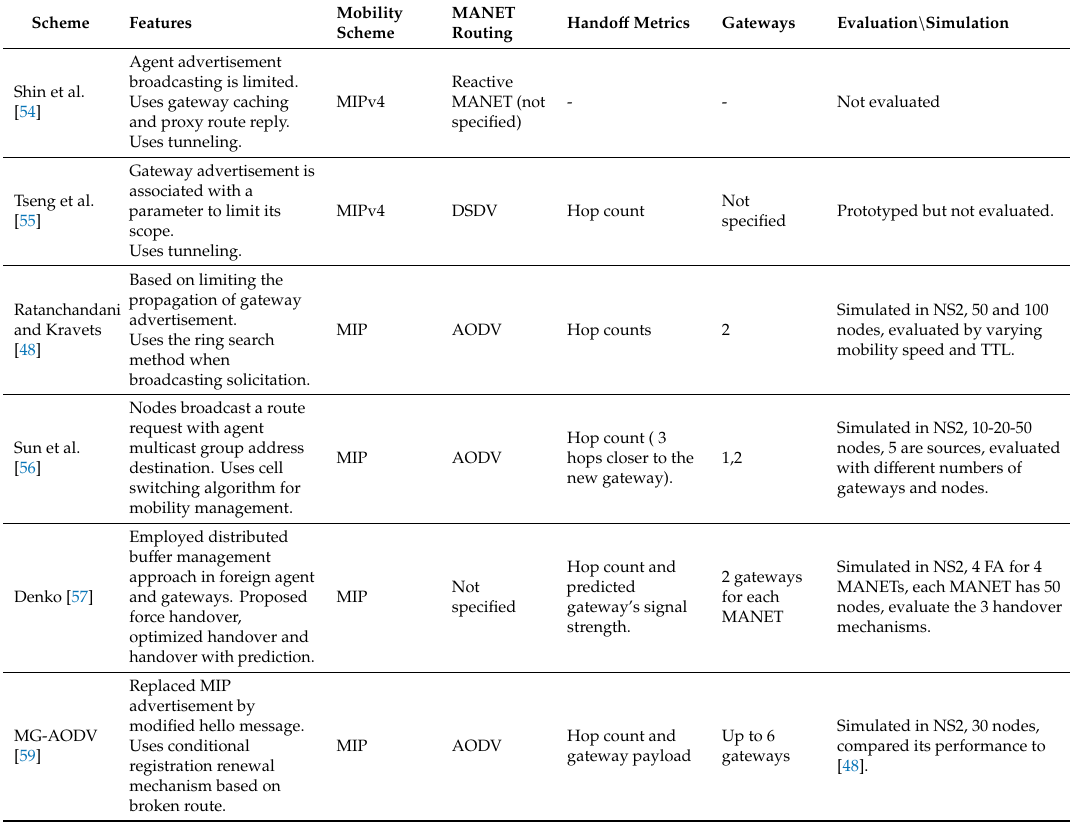
Table 3. Hybrid gateway discovery-based mobility management